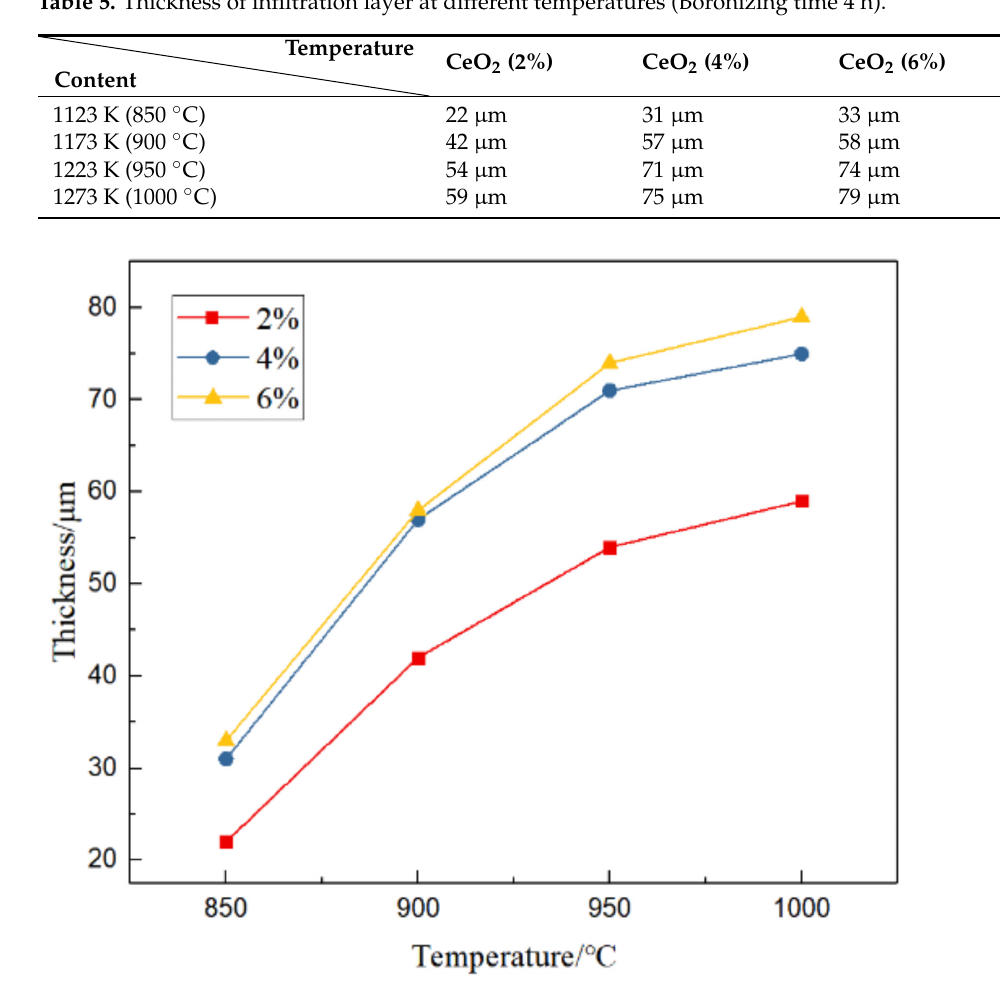
Figure 1. The increase of thickness of boronizing layer with solution and temperature (4